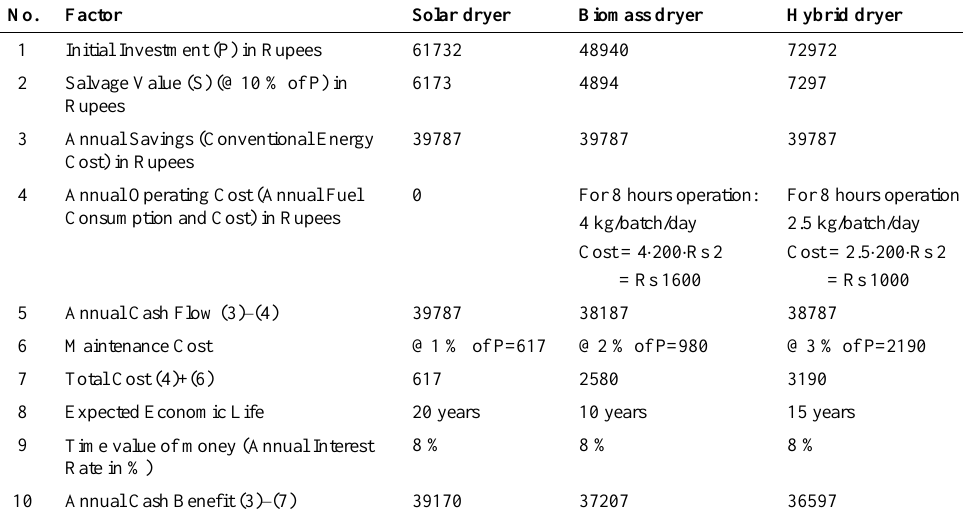
Table 4 comprises the data about the Factors like the Initial Investment, Salvage value, Annual Savings from conventional energy cost, operating and maintenance cost, expected economic life of asset, time value of money and annual cash benefit for all the three types of renewable energy based